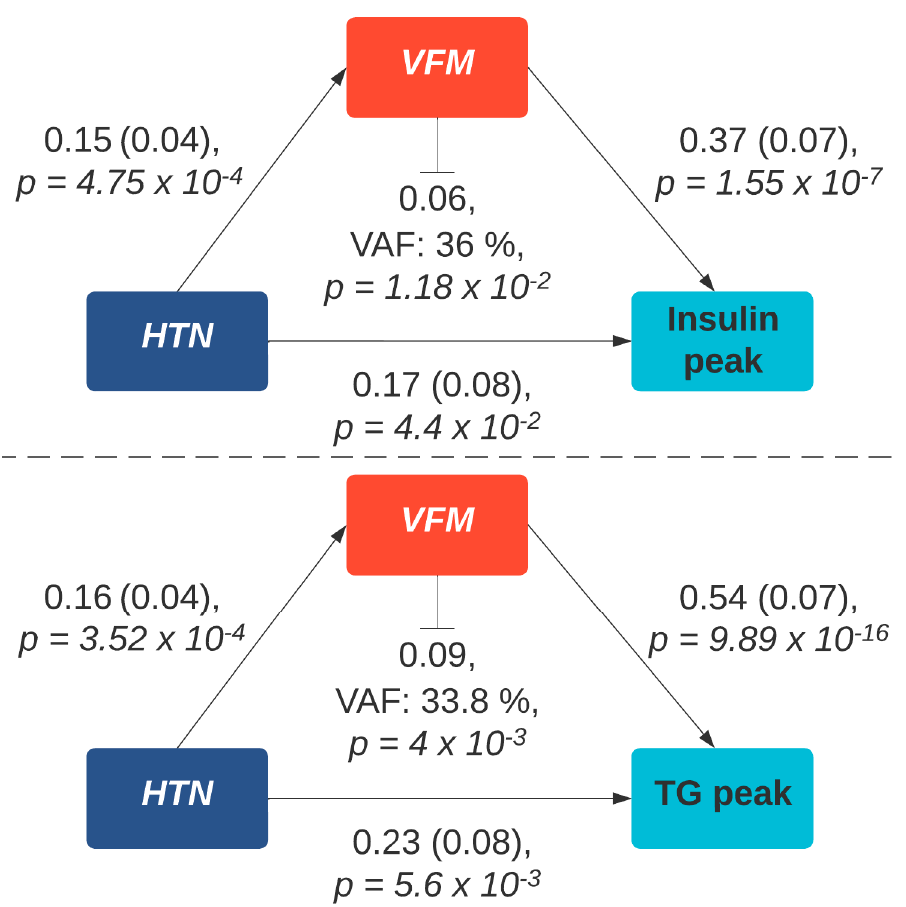
Figure 3. Mediation analysis of the association between hypertension and peak postprandial insulin and triglyceride response via visceral fat. Path coefficients are illustrated beside each path and indirect effect and variance accounted for score is denoted below the mediator. Abbreviations: TG, triglycerides; HTN, hypertension; VAF, variance accounted for.